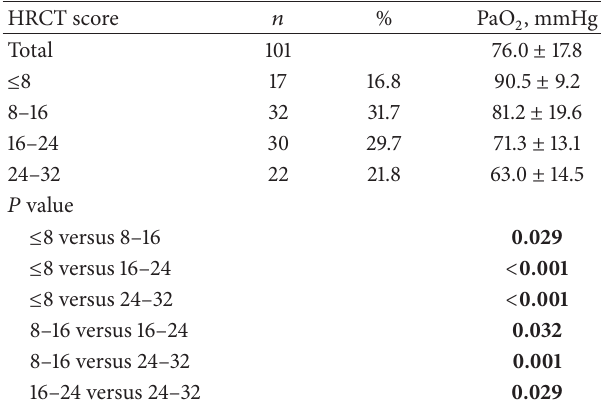
Table 2: Comparison of PaO 2 values between different groups according to DLCO, % predicted.